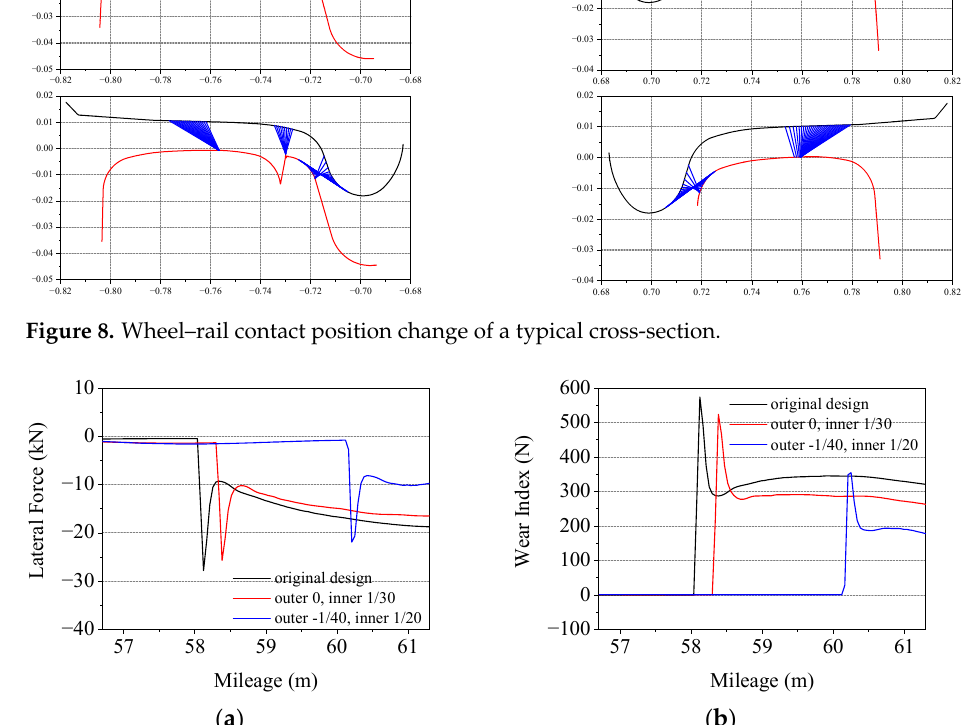
Figure 9. Calculation results of wheel–rail lateral force and wear index under different rail cant combination designs. ( a ) Lateral force; ( b ) Wear index.